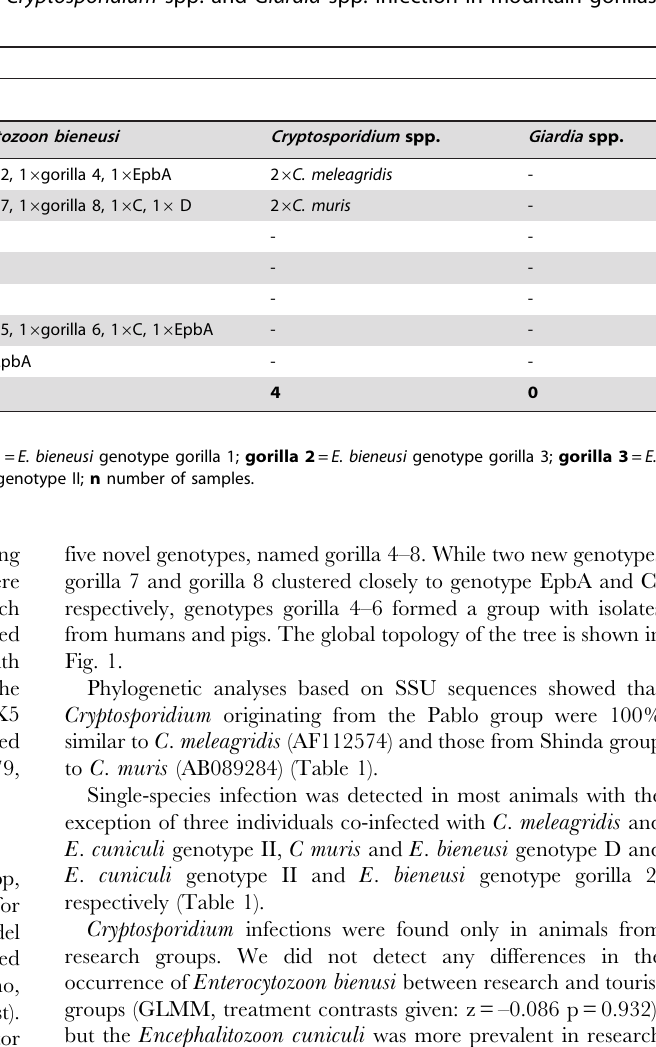
(Table 1). A phylogenetic analysis of all ITS sequences performed on a multiple alignment that included representatives of E.